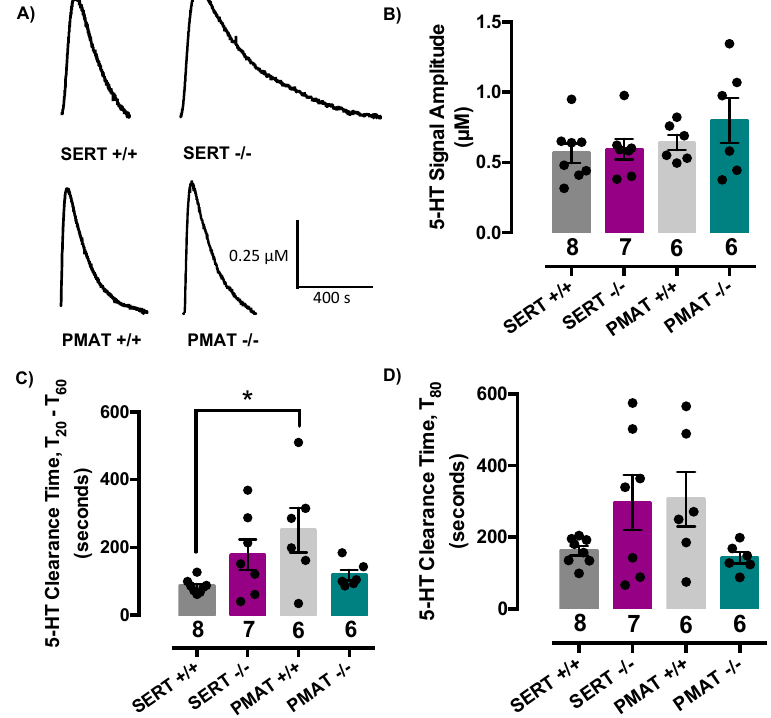
Figure 2. Comparison of serotonin clearance among serotonin transporter (SERT) and plasma membrane monoamine transporter (PMAT) genotypes. ( A ) Representative traces of basal serotonin clearance in SERT +/+ , SERT − / − , PMAT +/+ , and PMAT − / − mice. ( B ) Basal serotonin signal amplitude, and ( D ) T 80 clearance time did not differ significantly among genotypes. There was an effect of genotype in basal T 20 -T 60 serotonin clearance time ( C ) where PMAT+/+ cleared serotonin more slowly than SERT +/+ mice (but see Figure 3). Welch’s one-way ANOVA with Tukey’s post-hoc comparisons. * p < 0.05. Circles represent individual mice. Data are mean ± S.E.M.